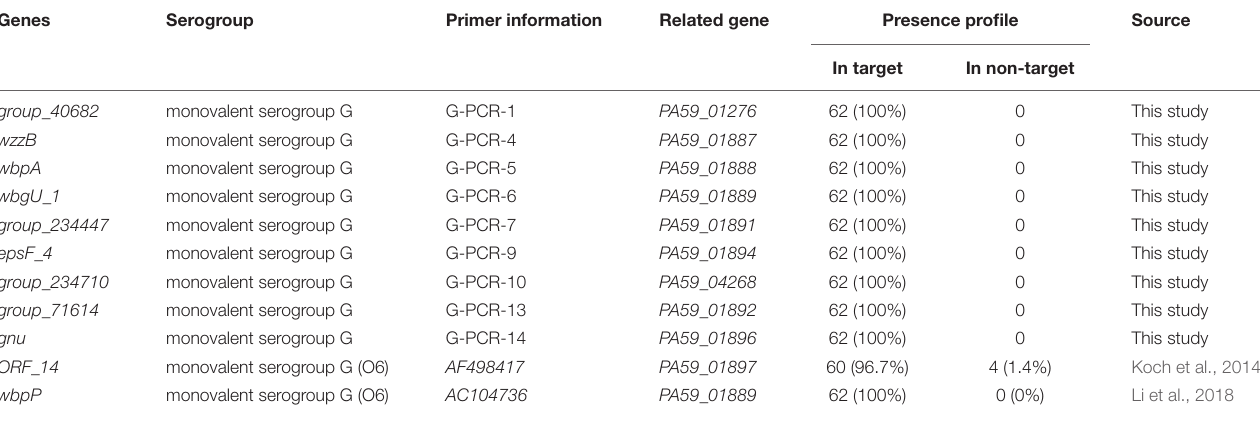
TABLE 4 | Presence profile of novel P. aeruginosa serogroup G-specific targets for target and non-target strains.